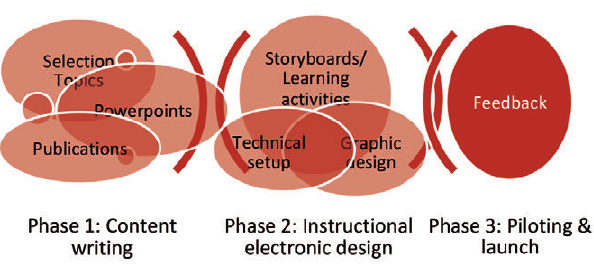
Figure 1. The development process of the Thal e-Course. Figure 2. A summary of the contents of the Thal